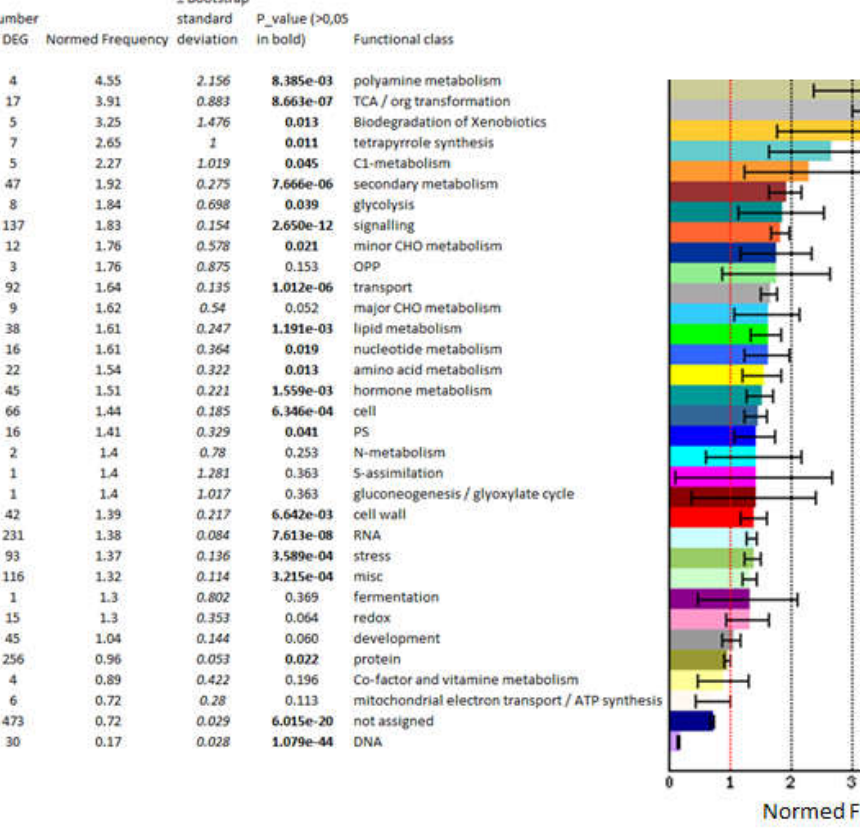
Figure 2: The 1845 DEGs with TAIR names have been classified according to MapMan functional categories. In order to highlight the enriched ones, a normed frequency of the relative proportion of each category in DEGs set (input set) and reference set (Arabidopsis genes in MapMan database) has been calculated as follows: sified reference_set )